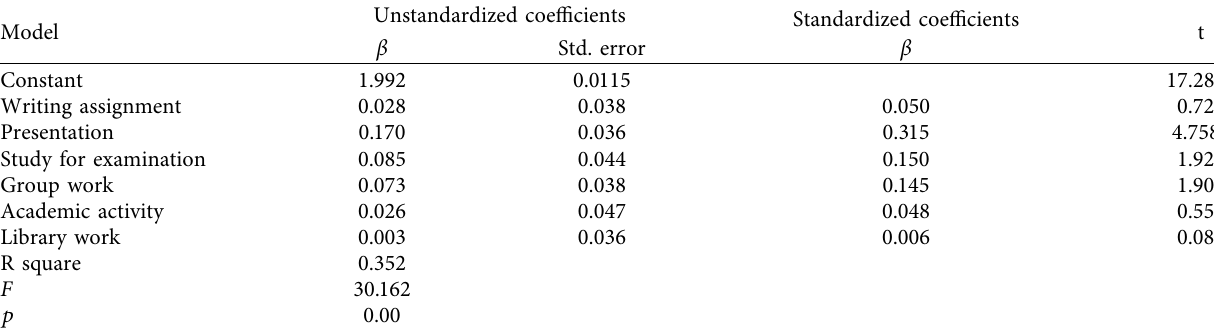
Table 2: Regression analysis results for the area of procrastination.